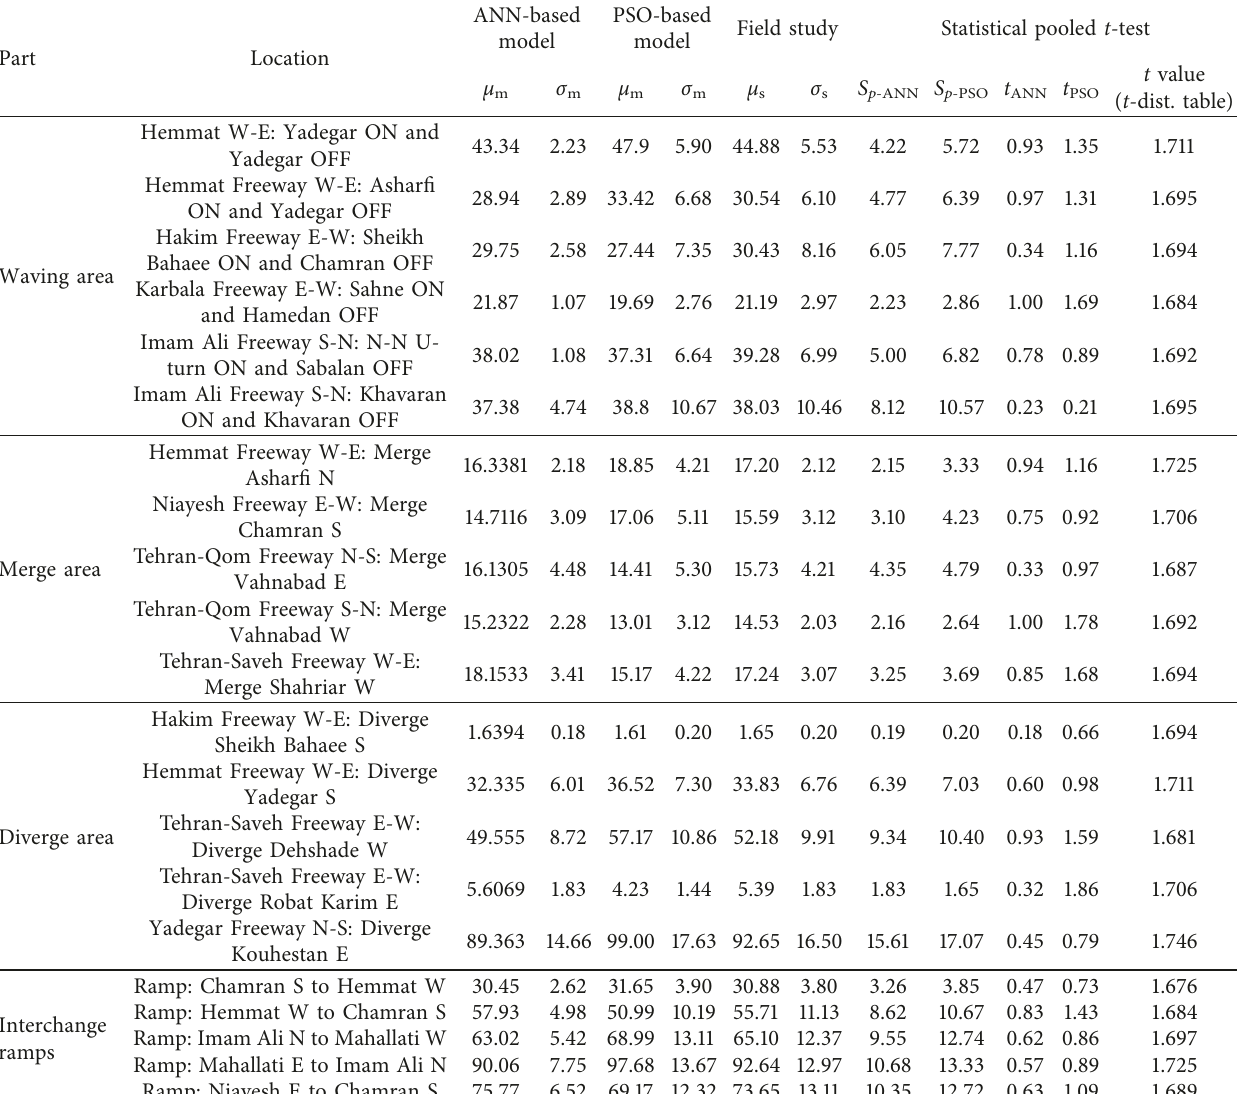
Table 6: Results of statistical analysis between means of the NCPIs estimated by the two safety estimator models versus the NCPIs achieved by field